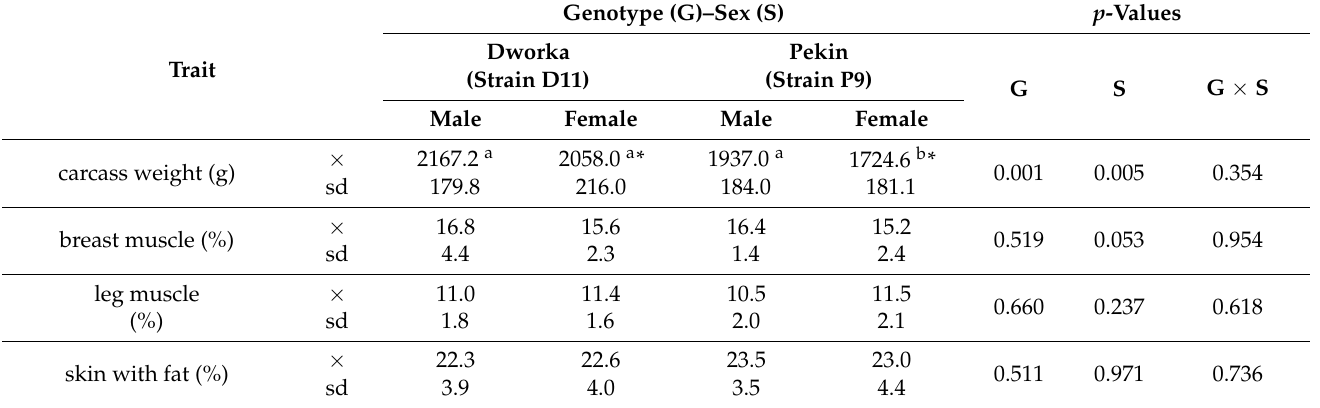
Table 1. Mean values ( × ) and standard deviation (sd) of the percentage of elements in the carcasses of 113-week-old